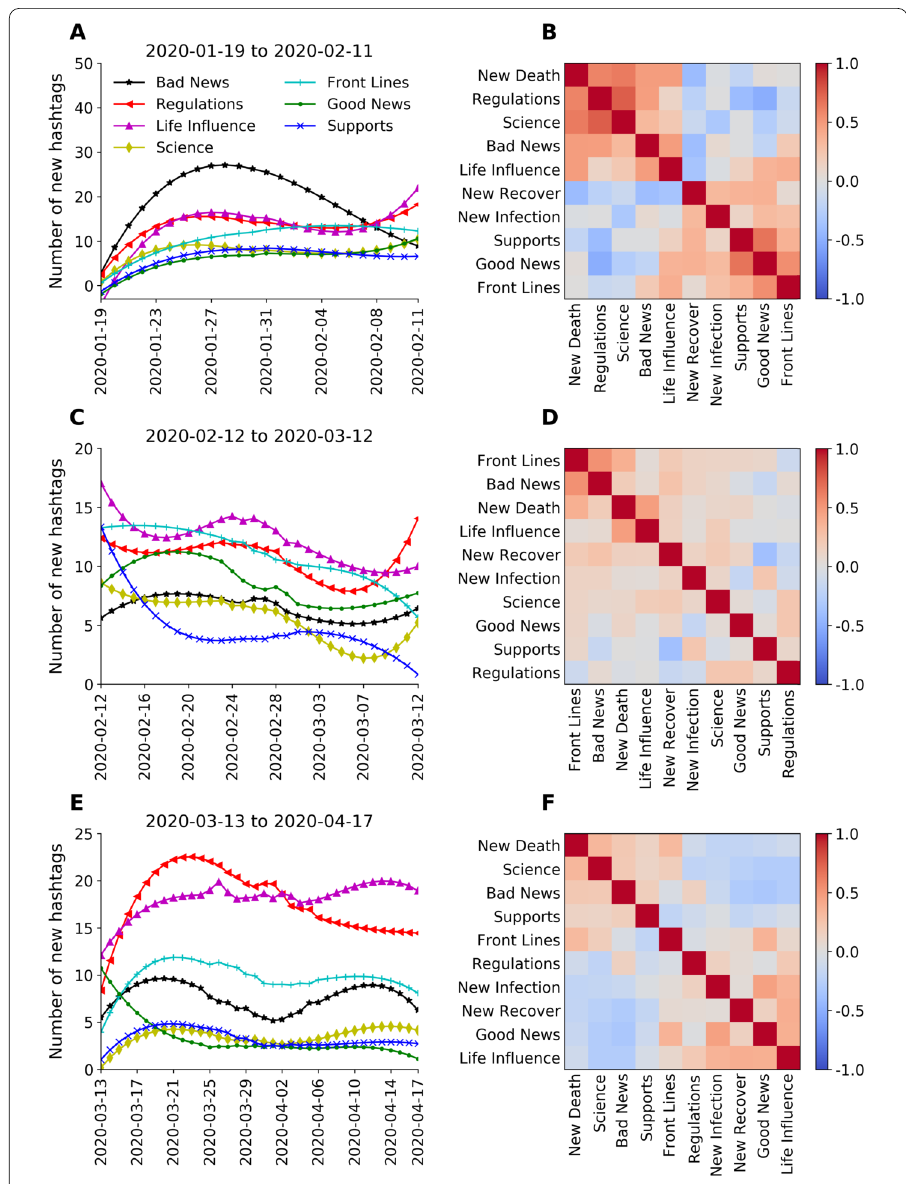
Figure 3 Time series of daily new hashtags (smoothened by a Savitzky-Golay filter [43] with polynomial order 3) from the sub-categories of Mainland China COVID-hashtags and their correlation matrices with daily new infections, deaths, and recoveries, in the three periods after the outbreak